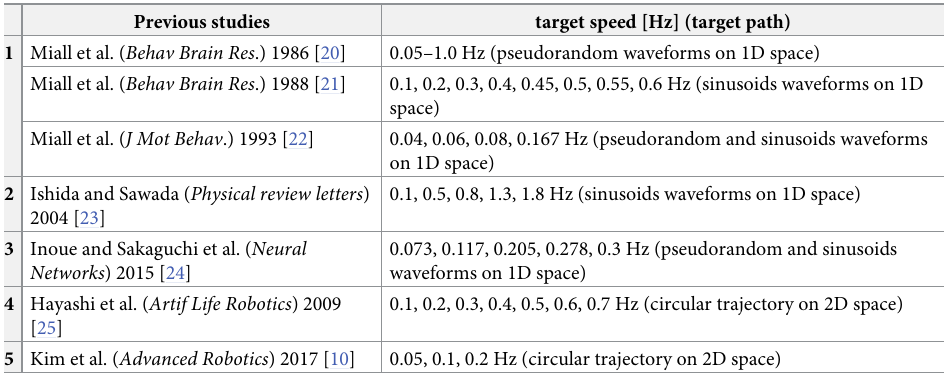
Table 2. Target velocities in tracking movement